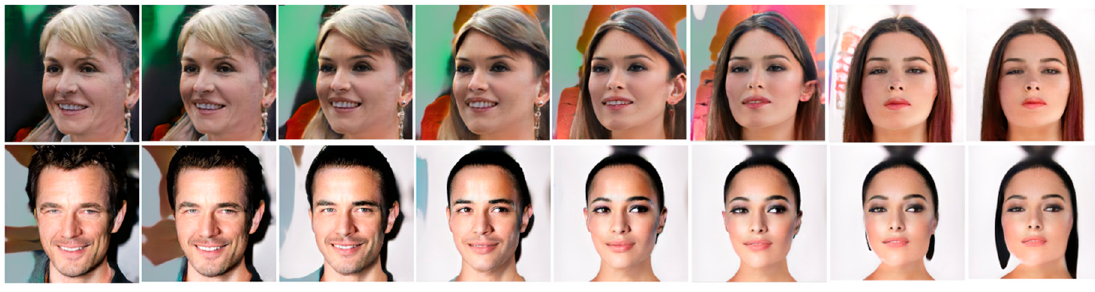
Figure 15. Synthetic effect of TL-GAN.